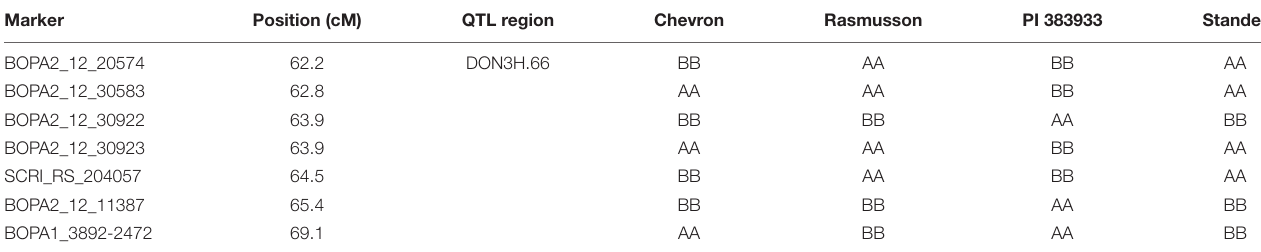
TABLE 5 | Marker haplotypes of Chevron, Rasmusson, PI 383933, and Stander in the chromosome 3H DON QTL region. Marker Position (cM) QTL region Chevron Rasmusson PI 383933